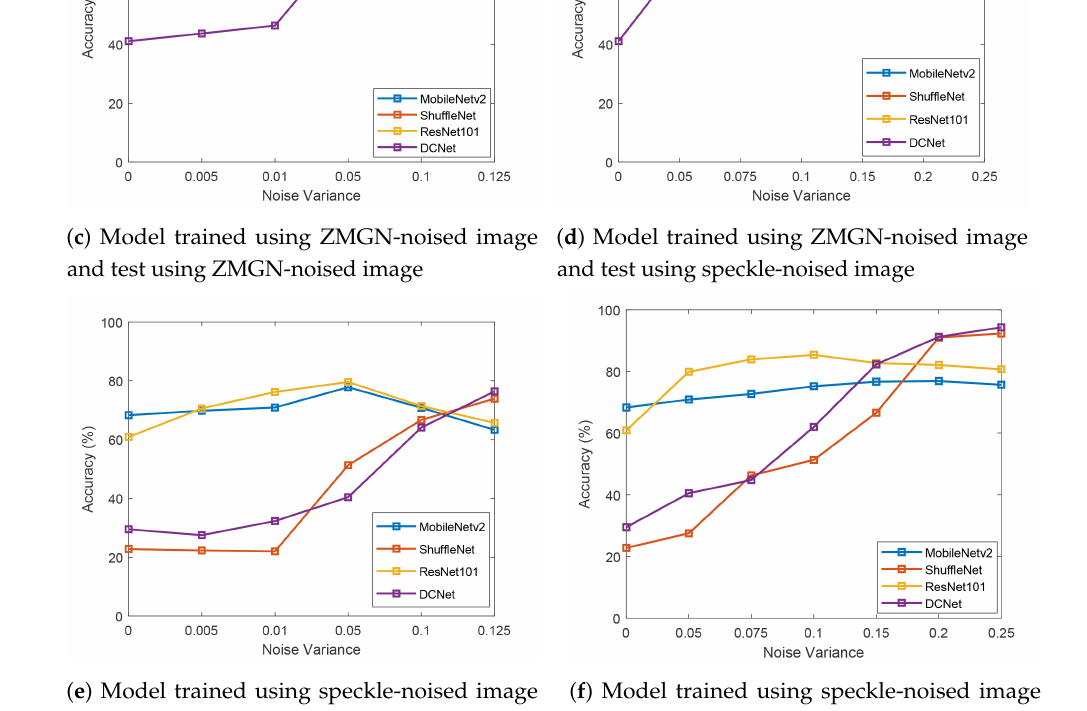
Figure 8. Testing results on different convolutional neural network (CNN) models and